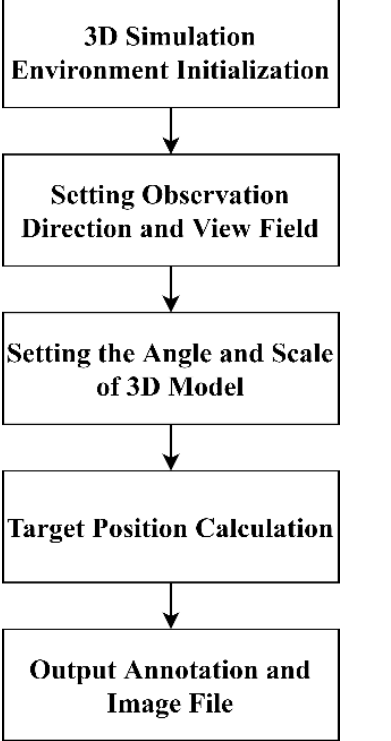
Figure 3. Ship image generation process based on computer simulation.